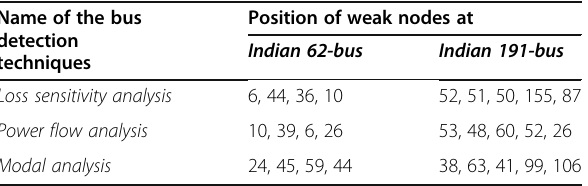
Table 5 Position of weak nodes/ buses for practical power